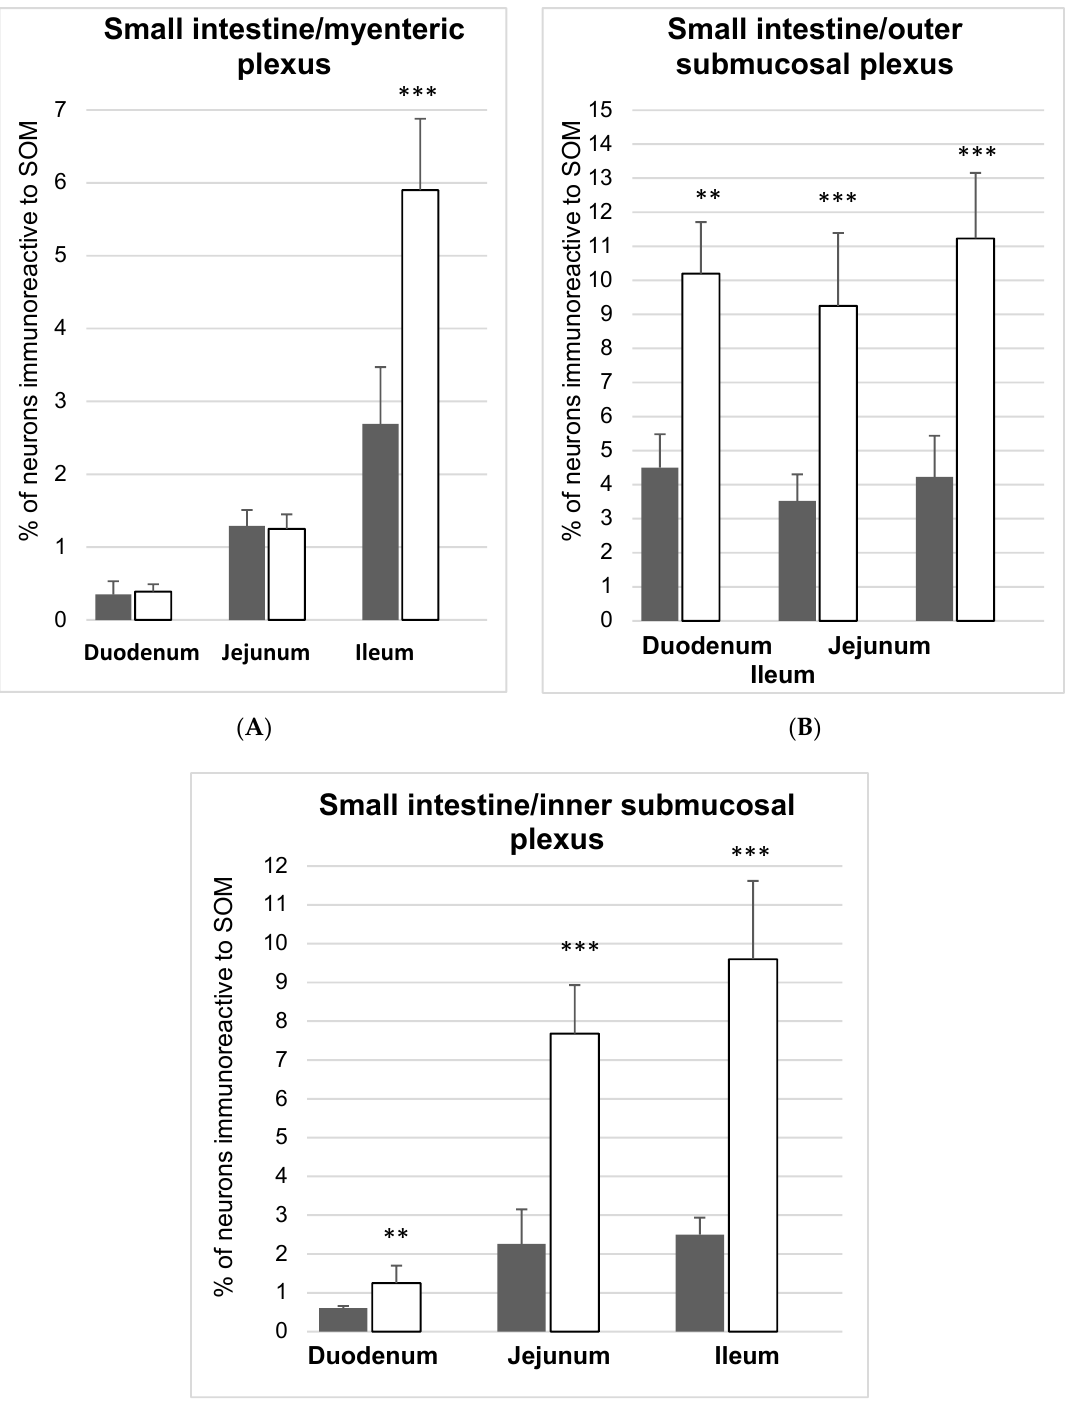
Figure 4. Mean (±SEM) of SOM, like immunoreactive (SOM-IL), neurons in the myenteric plexus ( A ), outer submucosal plexus ( B ) and inner submucosal plexus ( C ) of the small intestine in the control (grey bars) and streptozotocine-induced diabetes groups (white bars). Data are presented as mean ± SEM and statistically significant data (* p < 0.05, ** p < 0.01, and *** p < 0.001).